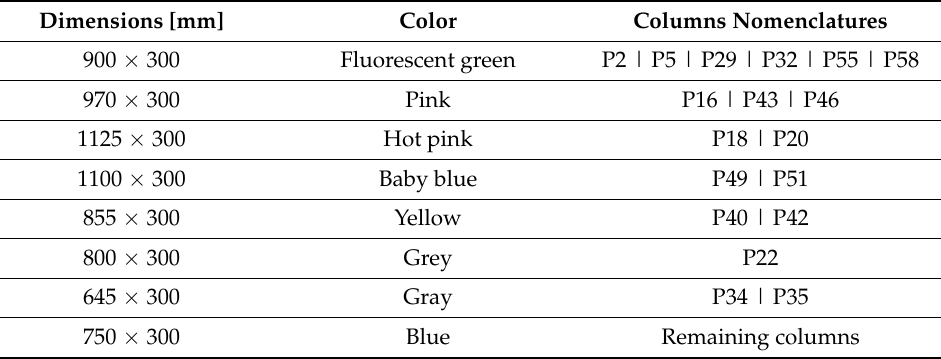
Figure 3. Case study: columns cross-section. Table 1. Case study: columns cross-section and nomenclature Dimensions [mm].